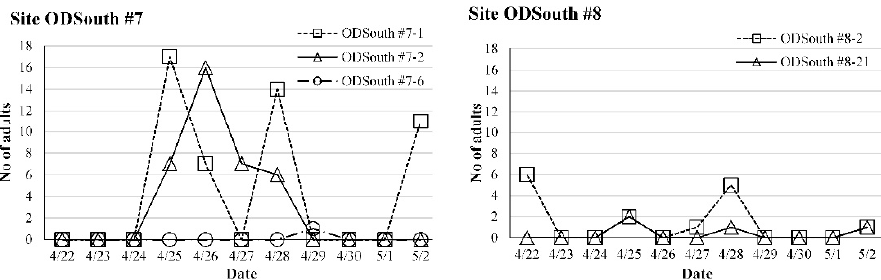
Figure 2. Seasonal abundance of O. kuvanae by egg mass on different oviposition sites based on laboratory incubation of L. delicatula eggs in 2016.